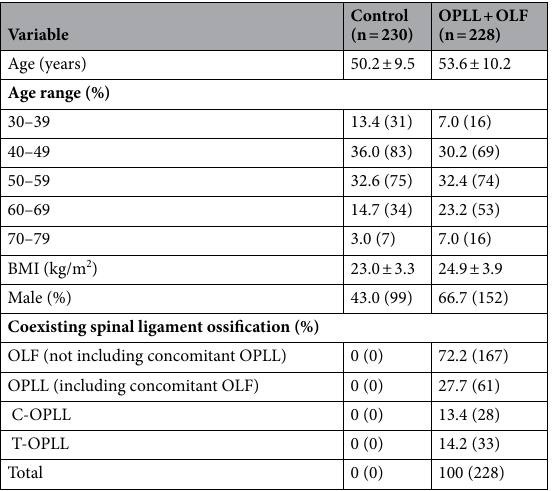
Table 1. Comparison of clinical characteristics between subjects without ligamentous ossification (control group) and those with OPLL and OLF. Data are shown as mean ± SD or as percentage (number). OPLL, ossification of the posterior longitudinal ligament; OLF, ossification of the ligamentum flavum; BMI, body mass index; C, cervical; T,